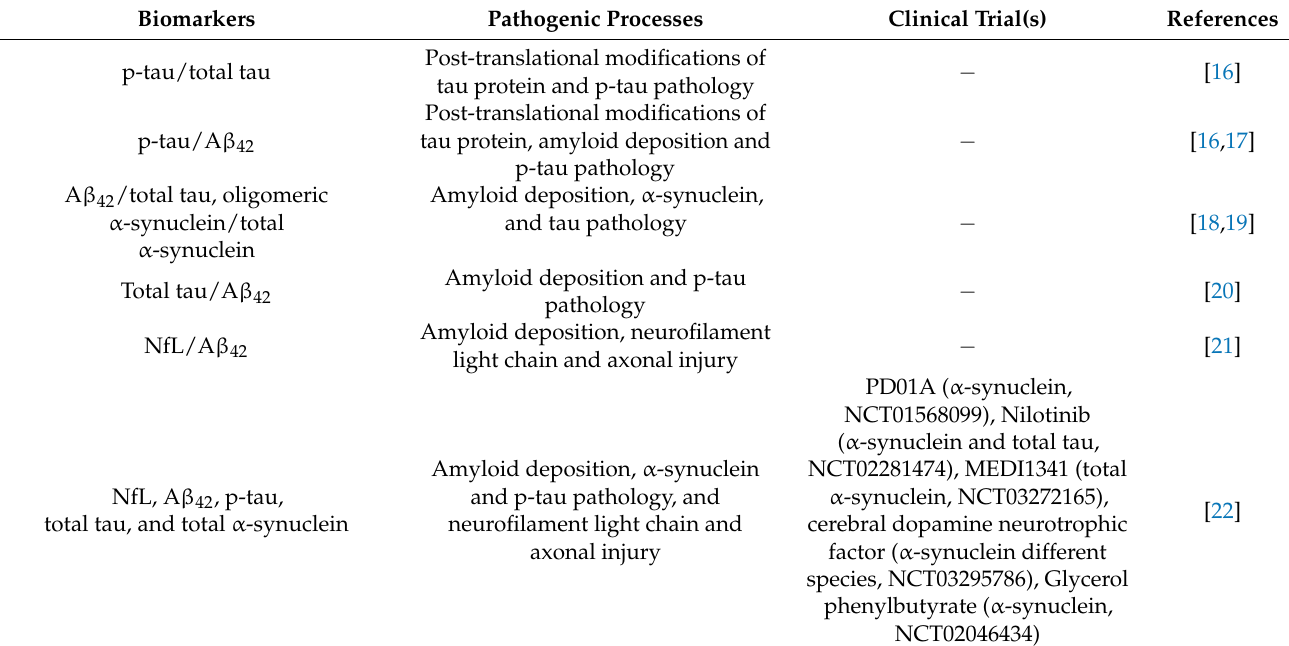
Table 1. Summary of candidate biomarkers of Parkinson’s